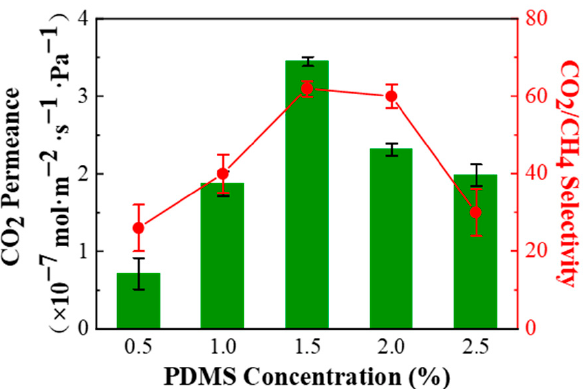
Figure 4. Effect of different PDMS concentrations on the CO 2 /CH 4 (45/55 vol%) mixed gas separation performance of PPPS/PDMS/PSf composite membrane. Test conditions: 298 K, saturated humidity, and 0.15 MPa.